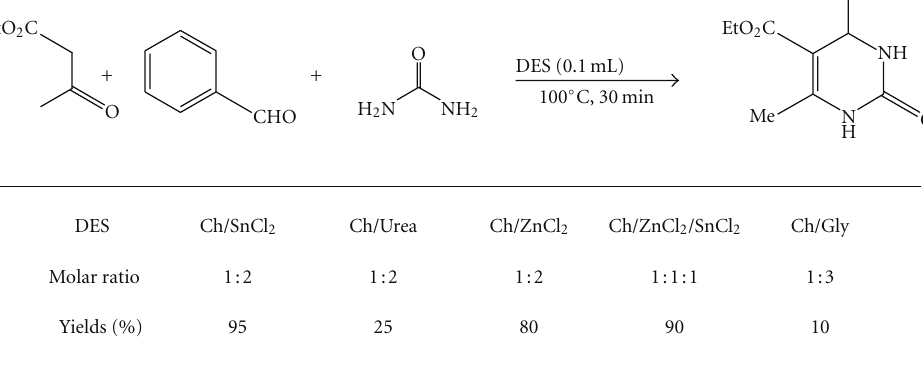
Scheme 1: Optimization of reaction